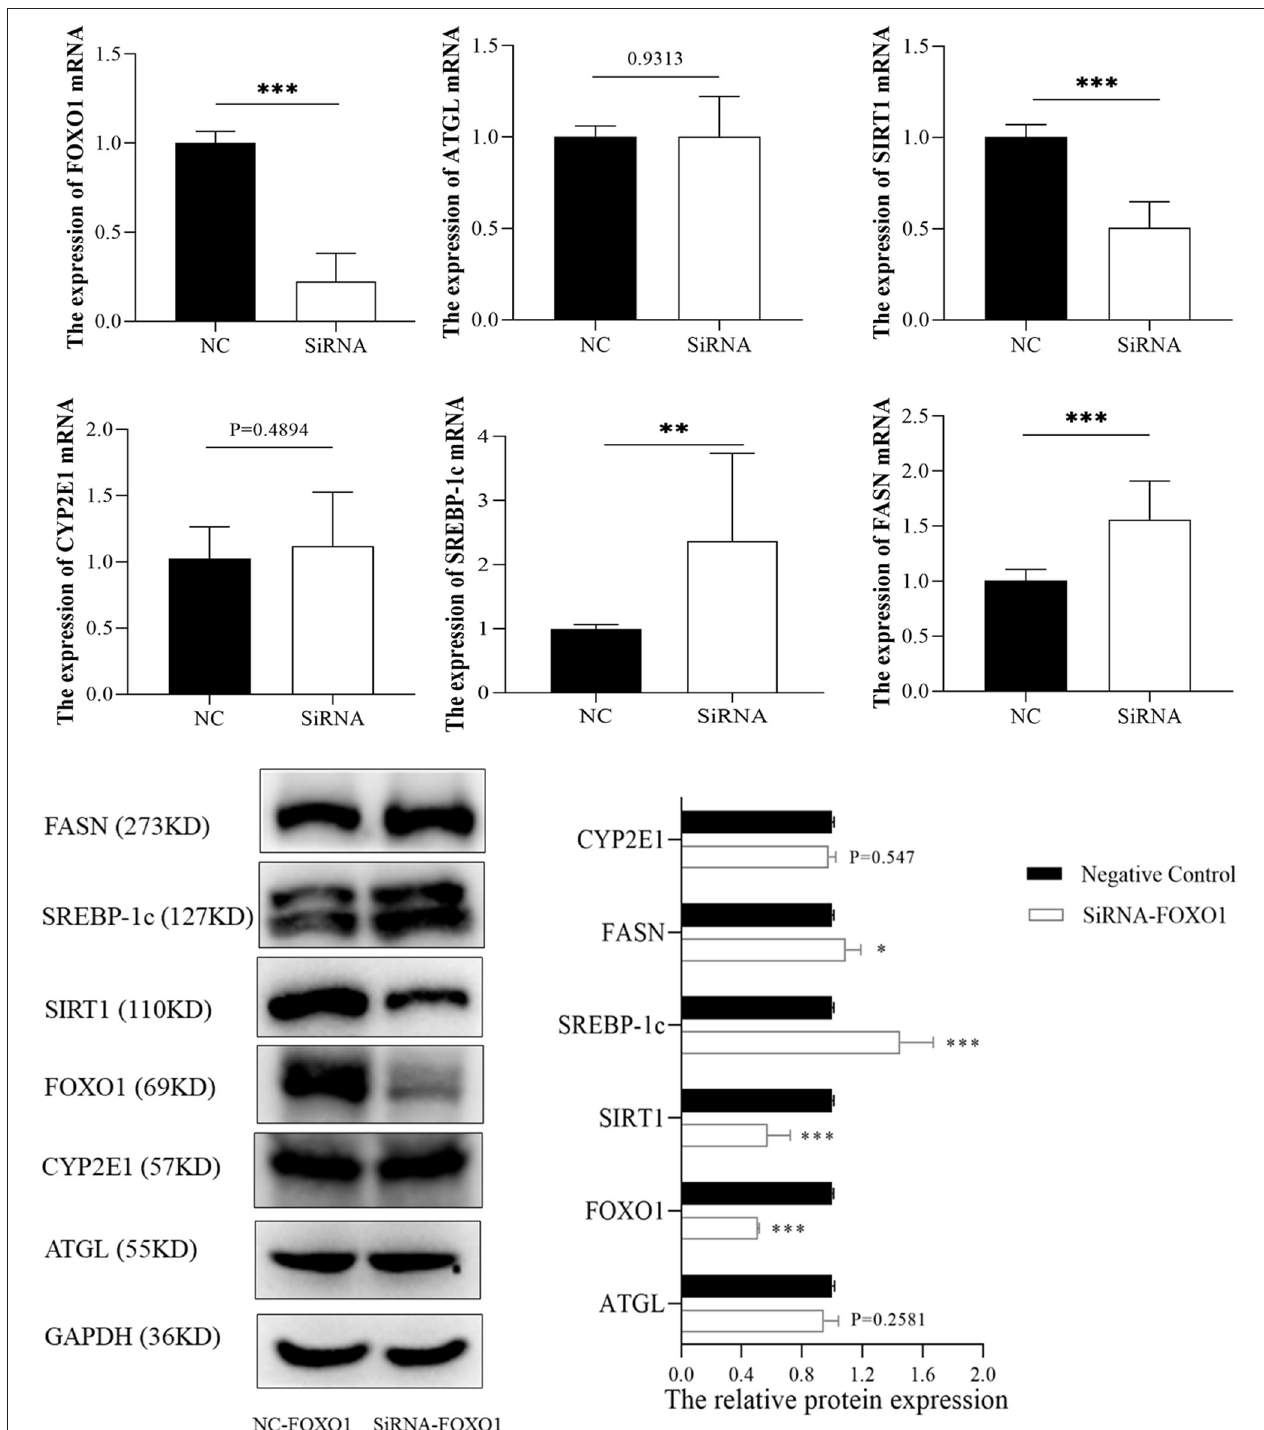
FIGURE 7 | The expression of FOXO1 downstream genes between siRNA and negative control groups. * p < 0.05, ** p < 0.01, *** p < 0.001. NC, negative control.